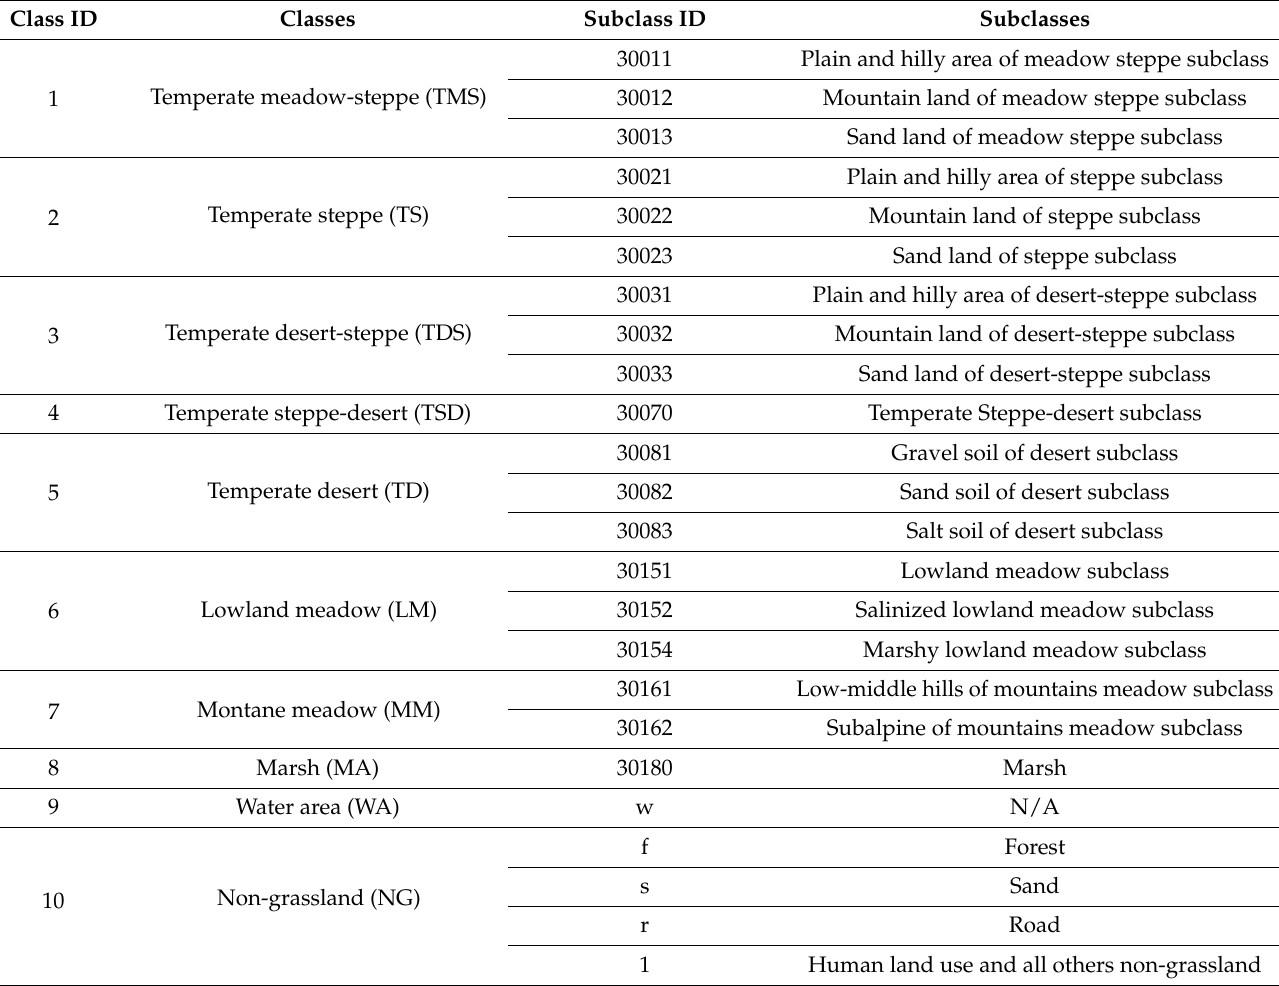
Table 1. IMAR LULC classes including grassland